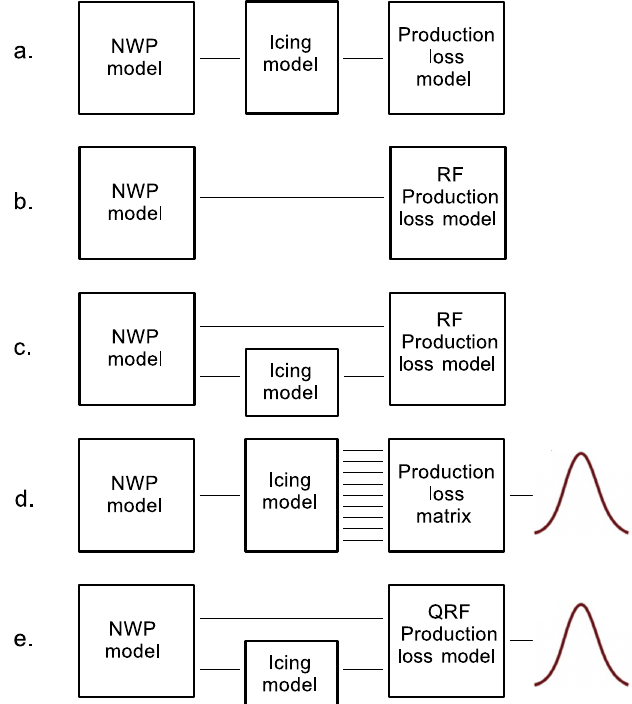
Figure 1. Modelling chain for different methods. ( a ). The baseline modelling chain for production loss forecasts. ( b ). The modelling chain used by Scher and Molinder [11]. ( c ). Adding the icing model to the modelling chain ( d ). Modelling chain according to Molinder et al. [8] and ( e ). The modelling chain for the QRF probabilistic forecast. Probability distribution in the end illustrate that both modelling chain d and e produce probabilistic output. RF = Random Forest, QRF = Quantile regression